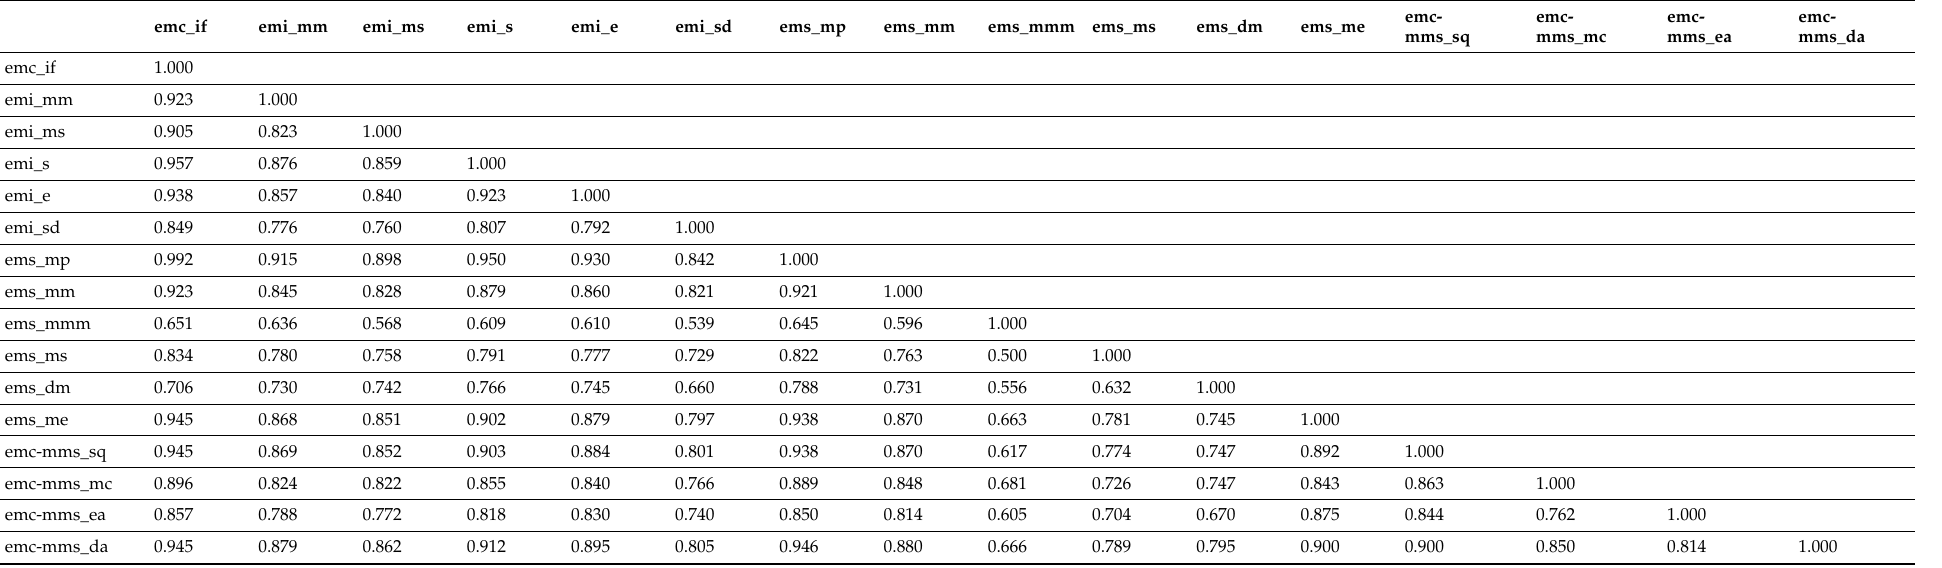
Table A6. Indicator